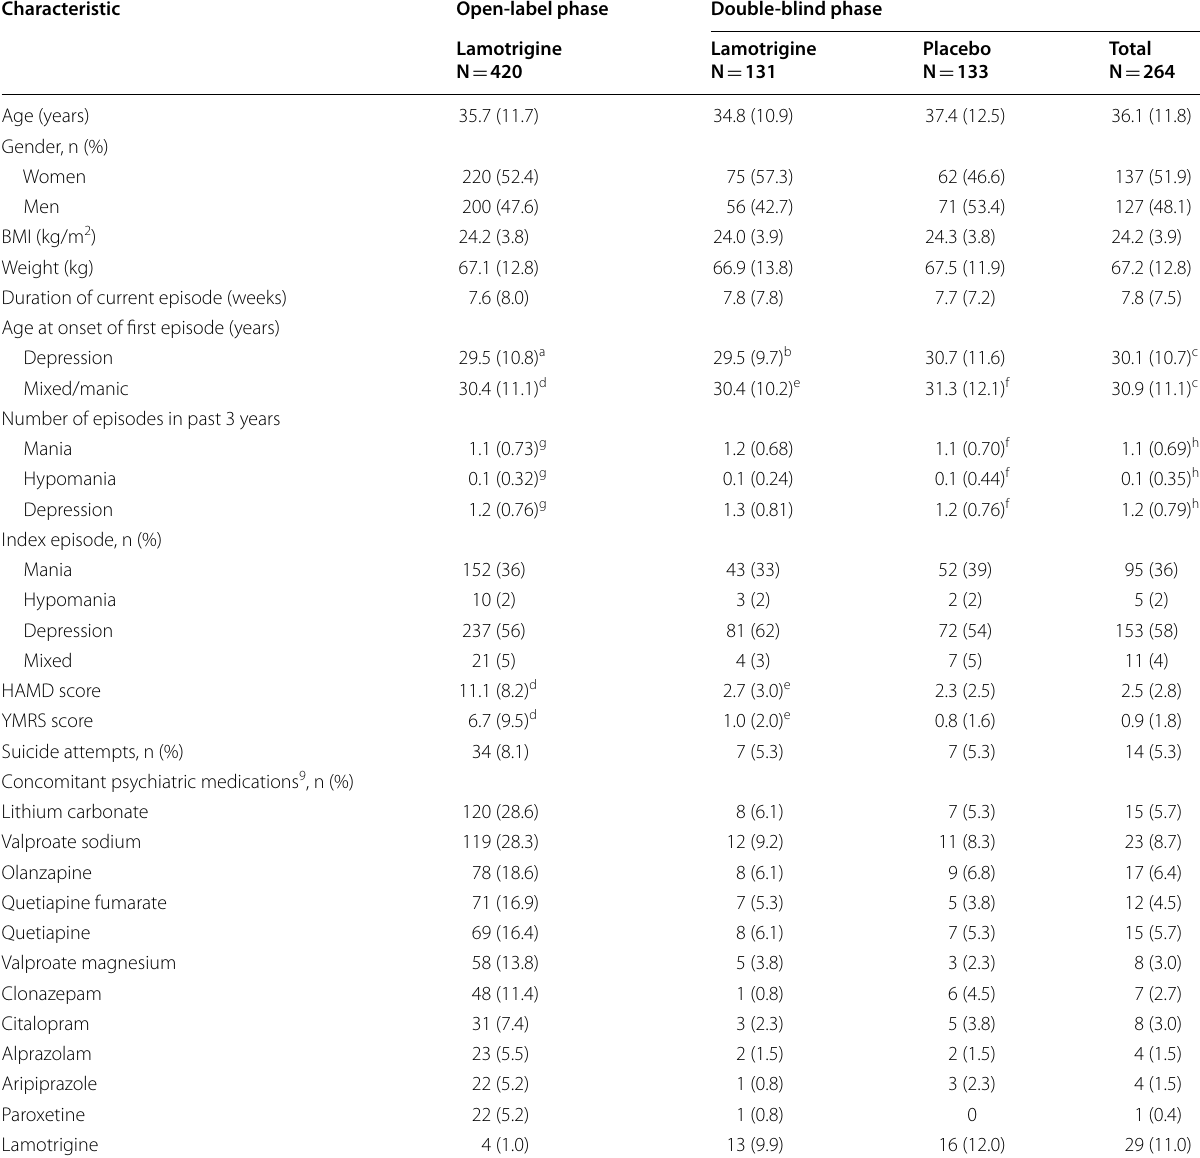
Table 1 Demographics and baseline